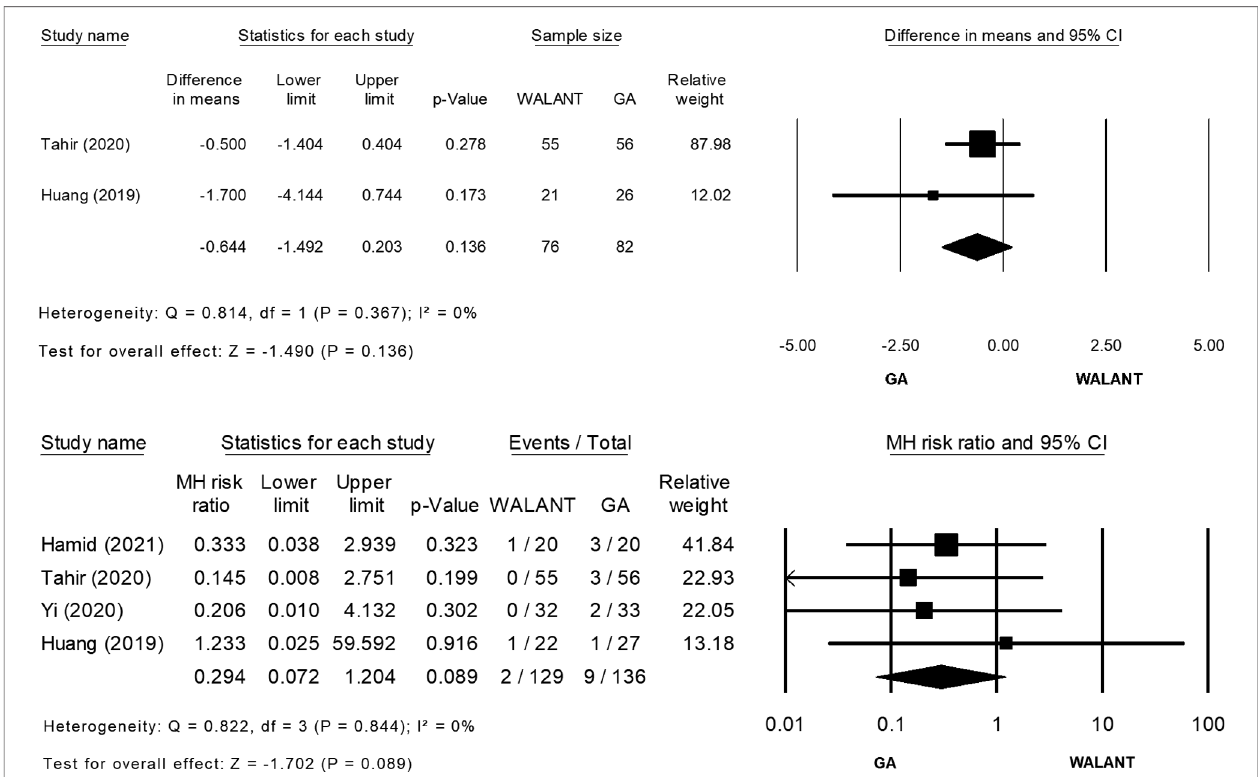
FIGURE 2 | ( A ) Forest plot of Preparation time for surgery (minute) comparing WALANT with GA. ( B ) Forest plot of Surgery time (minute) comparing WALANT with GA. ( C ) Forest plot of Blood loss (mL) comparing WALANT with GA. ( D ) Forest plot of Postoperative Hospital stays comparing WALANT with GA. ( E ) Forest plot of Post-operation day 1 visual analog scale (VAS) comparing WALANT with GA. ( F ) Forest plot of Mayo Wrist score comparing WALANT with GA. ( G ) Forest plot of Quick DASH score comparing WALANT with GA. ( H ) Forest plot of Wrist Flexion (degree) comparing WALANT with GA. ( I ) Forest plot of Wrist Extension (degree) comparing WALANT with GA. ( J ) Forest plot of Union time (week) comparing WALANT with GA. ( K ) Forest plot of Complication rate comparing WALANT with